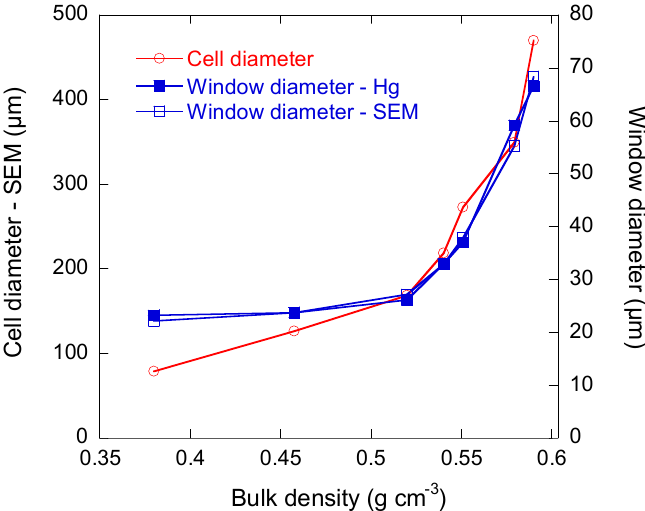
Figure 7. Average cell diameters derived from SEM observations, and window diameters measured either by mercury porosimetry or by SEM studies.